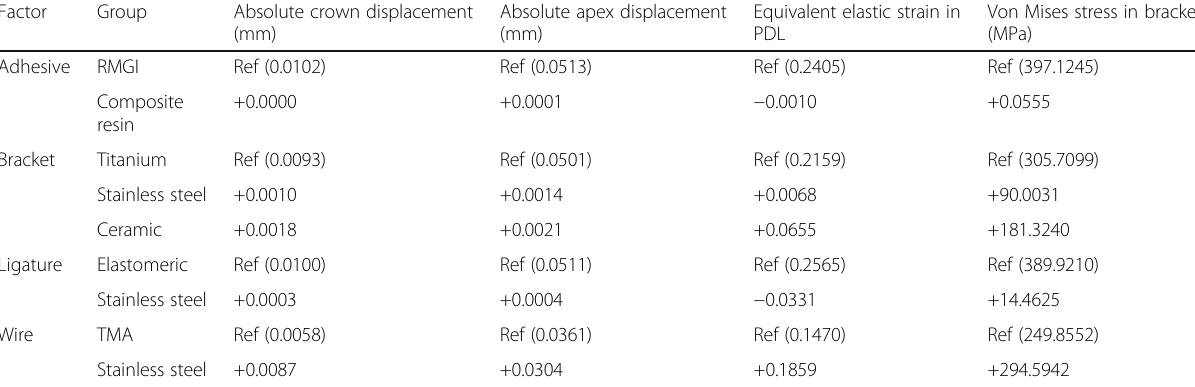
Table 2 Absolute changes in the various models according to the material of each